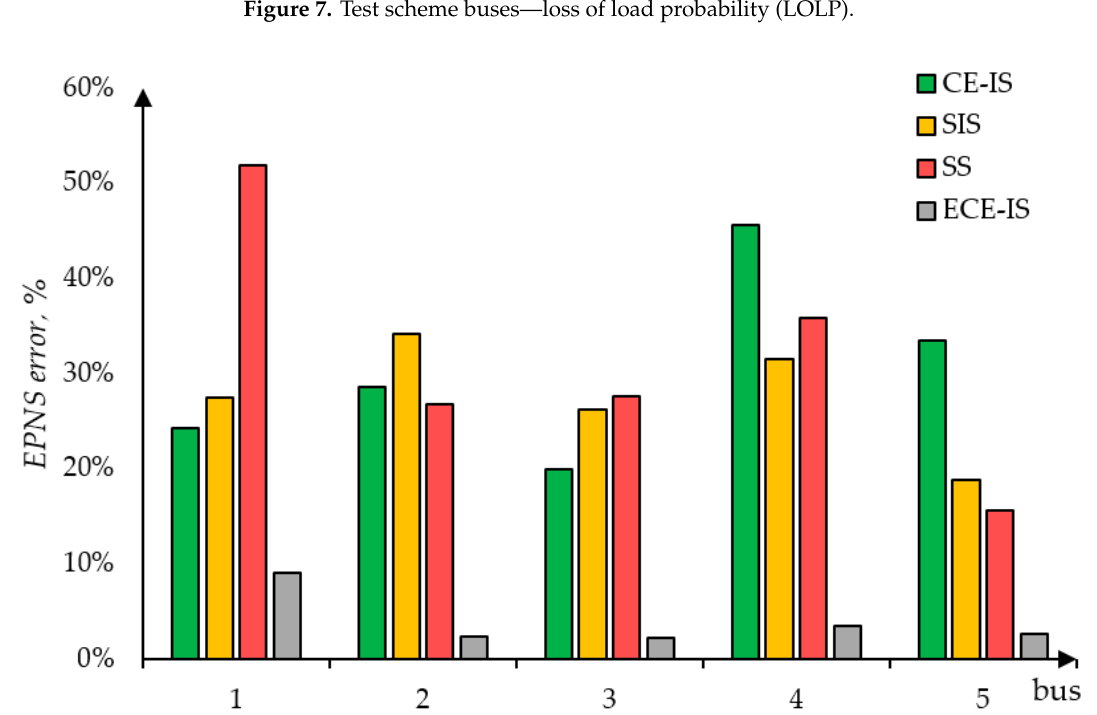
Figure 8. EPNS error compared to the standard Monte Carlo simulation (MCS) method.